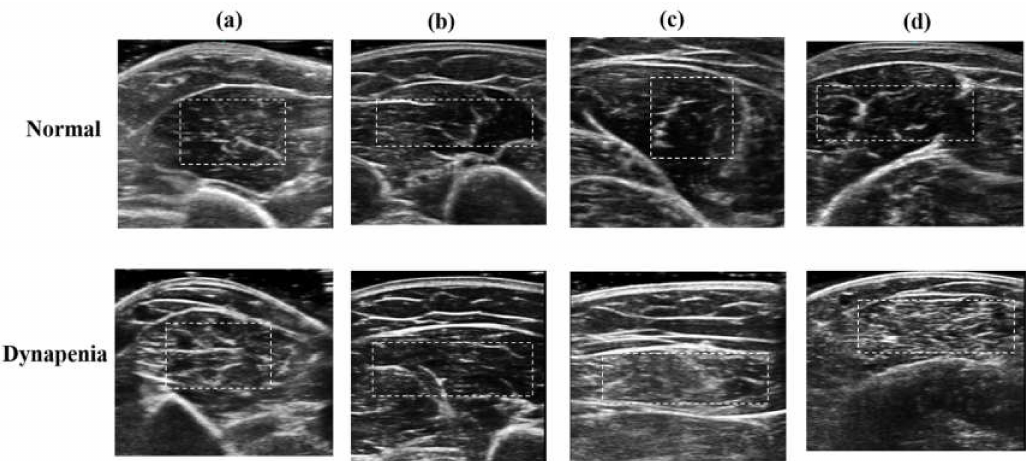
Figure 1. Di ff erent muscles of ultrasound B-mode images of a normal subject and a patient with dynapenia: ( a ) biceps brachii muscles, ( b ) triceps brachii muscles, ( c ) rectus femoris muscles, and ( d ) medial gastrocnemius muscles. The white dashed lines delineating the region of interest were manually traced by the